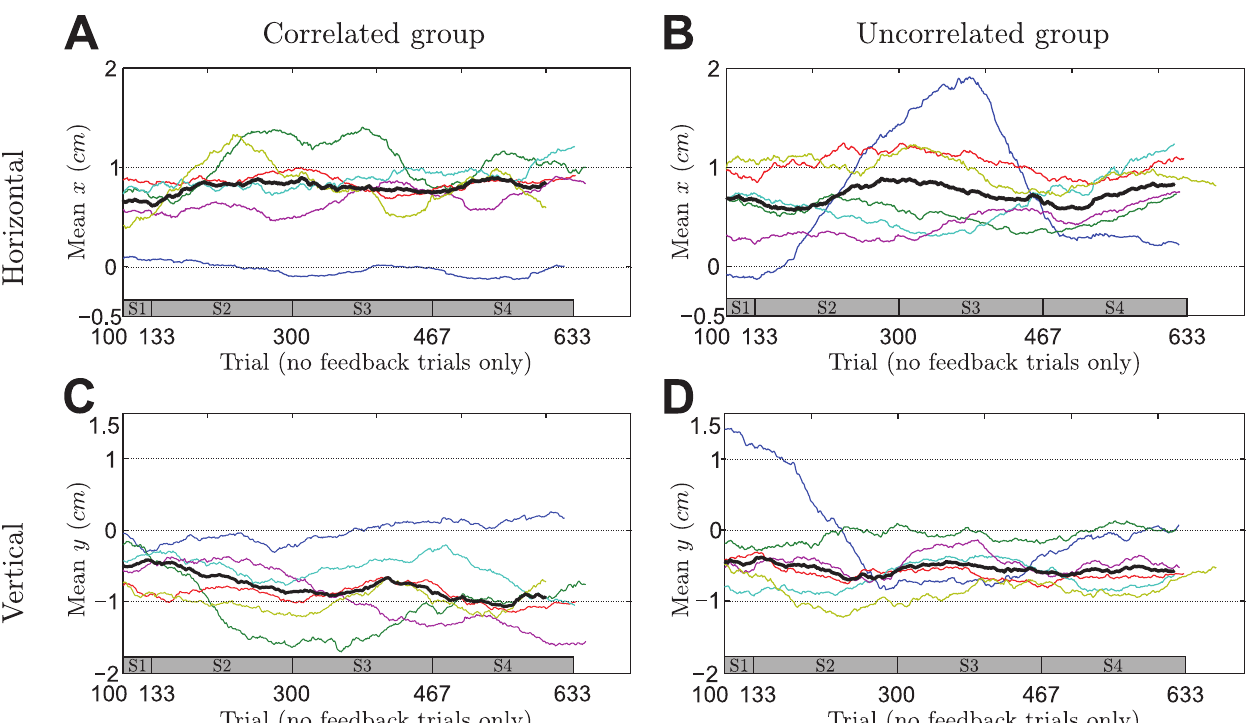
Fig 7. Learning of mean shift over all sessions revealed by performance in no-feedback trials averaged over a sliding window of 100 trials. A Learning of the mean in the horizontal dimension of the correlated group. B Same as A but showing data of the uncorrelated group. C Learning of the mean in the vertical dimension of the correlated group. D Same as C but showing data of the uncorrelated group. For the analysis only no-feedback trials were taken out from the pooled data across all sessions. Thin colored lines indicate individual participants and can vary in length since the exact number of relevant trials could fluctuate due to the probabilistic generation of trials. The thick black line shows the median over participants — taking only into account trials where data from all participants exists. The bar at the bottom of the figure indicates the corresponding session (on average).